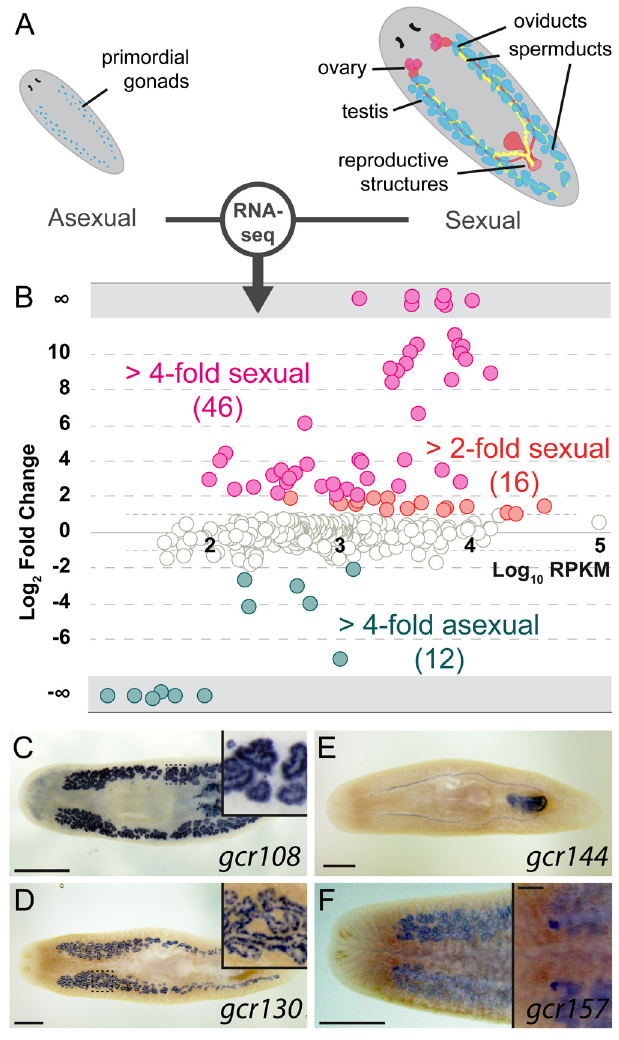
Fig 4. A subset of planarian GPCRs is enriched in reproductive tissues. (A) Schematic of the reproductive system in the two biotypes of S . mediterranea . Sexual planarians (right) develop a complete reproductive system, including mature gonads and accessory reproductive organs. The asexuals (left) contain only presumptive gonads with PGCs. (B) Normalized RNA-seq RPKM ratios between sexual and asexual planarians plotted against relative abundance of each GPCR gene. Only data points with p - value < 0.05 are shown. (C – F) Representative colorimetric ISH experiments used to validate RNA-seq results ( n = 24/27 genes tested expressed in sexual organs). Sexually enriched genes are expressed in various reproductive tissues, including spermatids (C), spermatogonia (D and F), oviducts and female copulatory apparatus (E), and ovaries (F). Scale bars are 1 mm. Insets in C and D show the area inside the dashed box. Inset in F shows the ventral side and the scale bar is 200 μ m. See also S4 Fig and S3